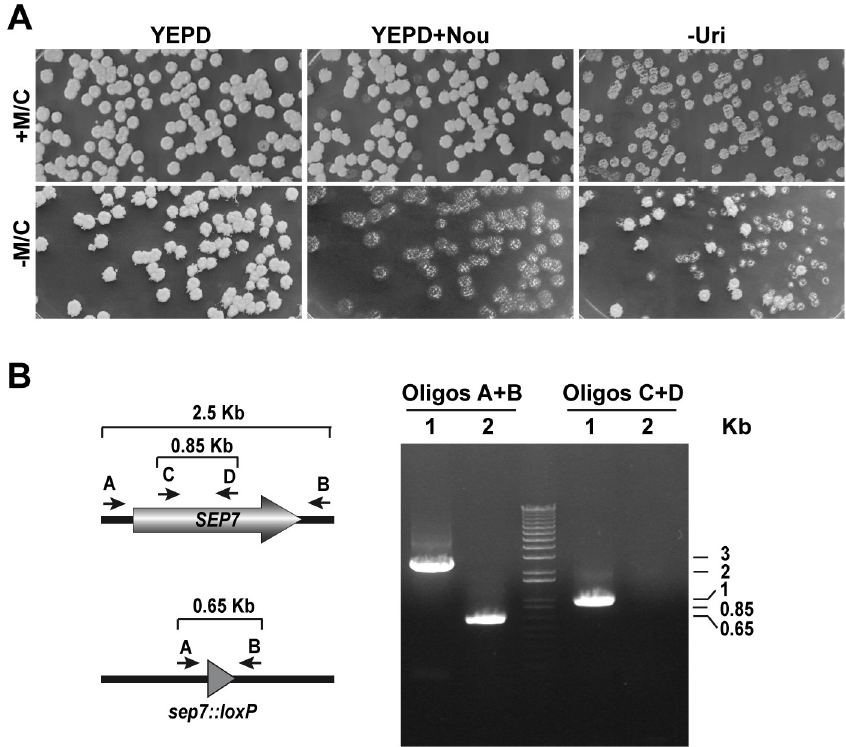
Fig 2. Construction of deletion mutants without selection markers. (A) The sep7 :: LUL/sep7 :: NAT1-Clox strain (OL2908) was grown overnight in YPD medium with (+M/C) or without (-M/C) methionine and cysteine to repress or induce the expression of the Cre recombinase respectively, and then plated on YPD medium. After 24 h of incubation at 28 º C, the plate was printed onto YPD+ nourseothricin or SC -Uri plates and incubated another 24 h. (B) PCR analysis of the different strains with specific SEP7 oligonucleotides. Genomic DNA was isolated from the parental strain BWP17 (1) and the sep7 :: loxP/sep7 :: loxP (2, OL2909) mutant and analyzed with two different oligonucleotide pairs, one annealing at the 5´ and 3´ flanking regions (A and B) and another internal to the coding region (C and D) to confirm correct integration and excision of the deletion cassettes. The position of the primers in the SEP7 locus and the sep7 :: loxP allele is depicted to the